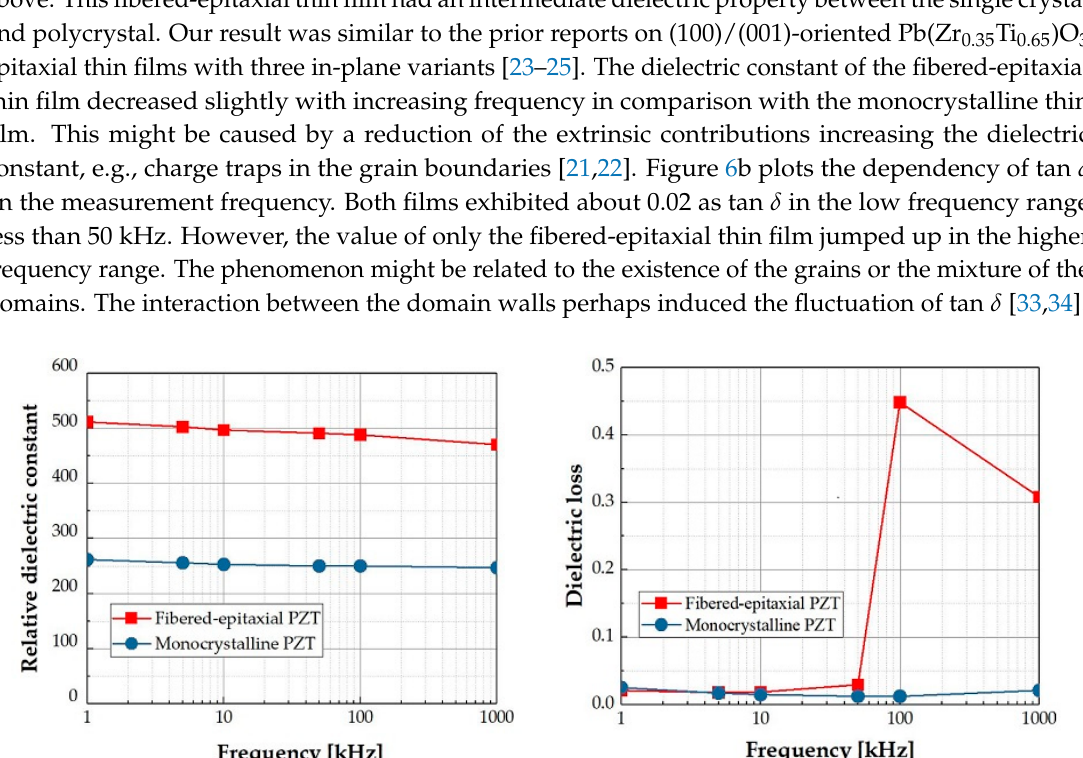
Figure 5. In-plane epitaxial relationships of ( a ) monocrystalline and ( b ) fibered-epitaxial films by pole figures.